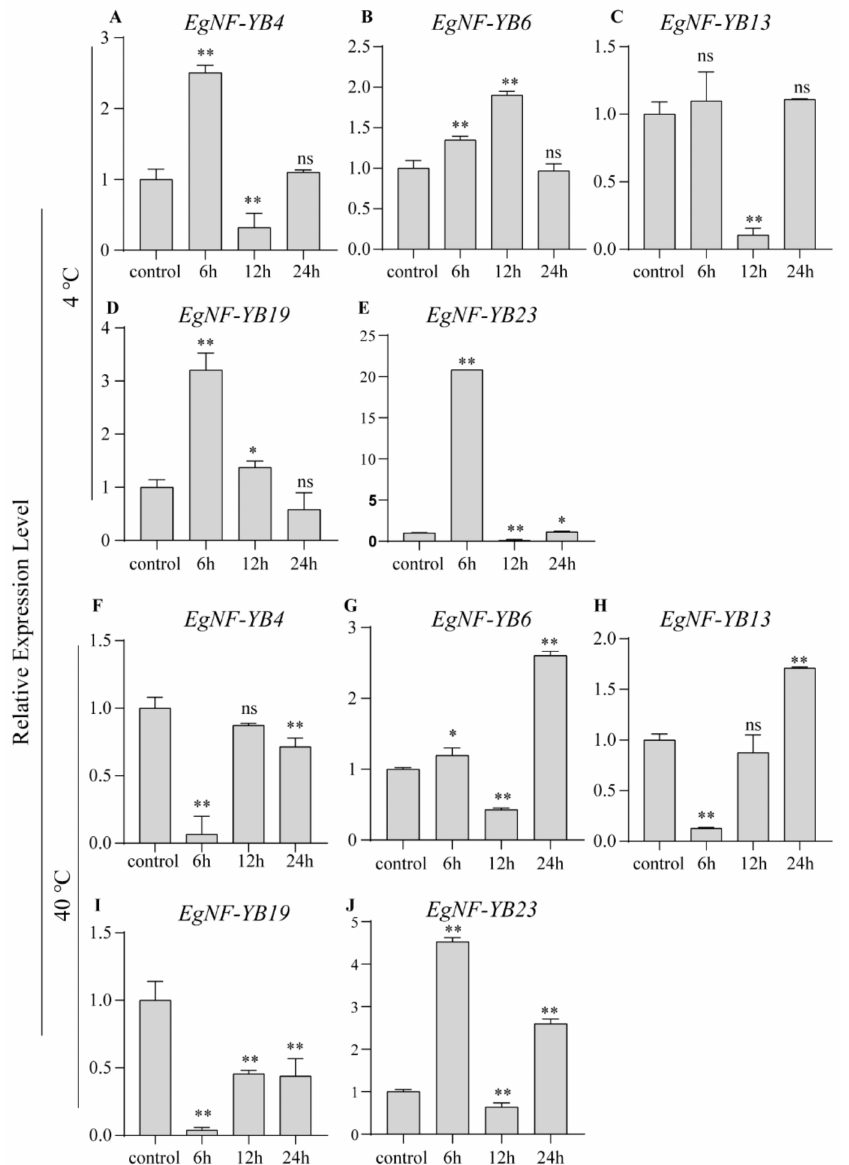
Figure 8. qRT-PCR expression analysis of five selected EgNF-YBs genes under temperature treatment. ( A – E ) low temperature (4 ◦ C); ( F – J ) high temperature (40 ◦ C). The processing time of each group was control(no treatment), 6 h, 12 h and 24 h. Mean expression value was calculated from three independent replicates. Error bars indicate the standard deviation. Data are presented as mean + standard deviation (SD). Asterisks on top of the bars indicate statistically significant differences between the stress and counterpart controls (* p < 0.05, ** p < 0.01 and ns >